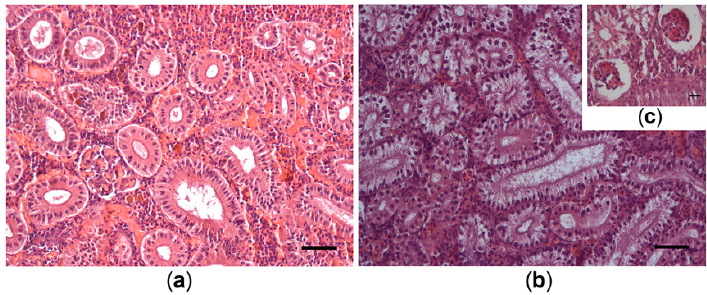
Figure 5. Histopathological alterations in the kidney of Prussian carp Carassius gibelio from Lake Ludoš, 2018: ( a ) control fish; ( b ) degeneration of tubules including vacuolization and separation of epithelial layer from the basal lamina; ( c ) reduction of glomeruli size and intense dilatation of Bowman’s capsule. H&E staining. A and B–50 μ m; C–20 μ m.